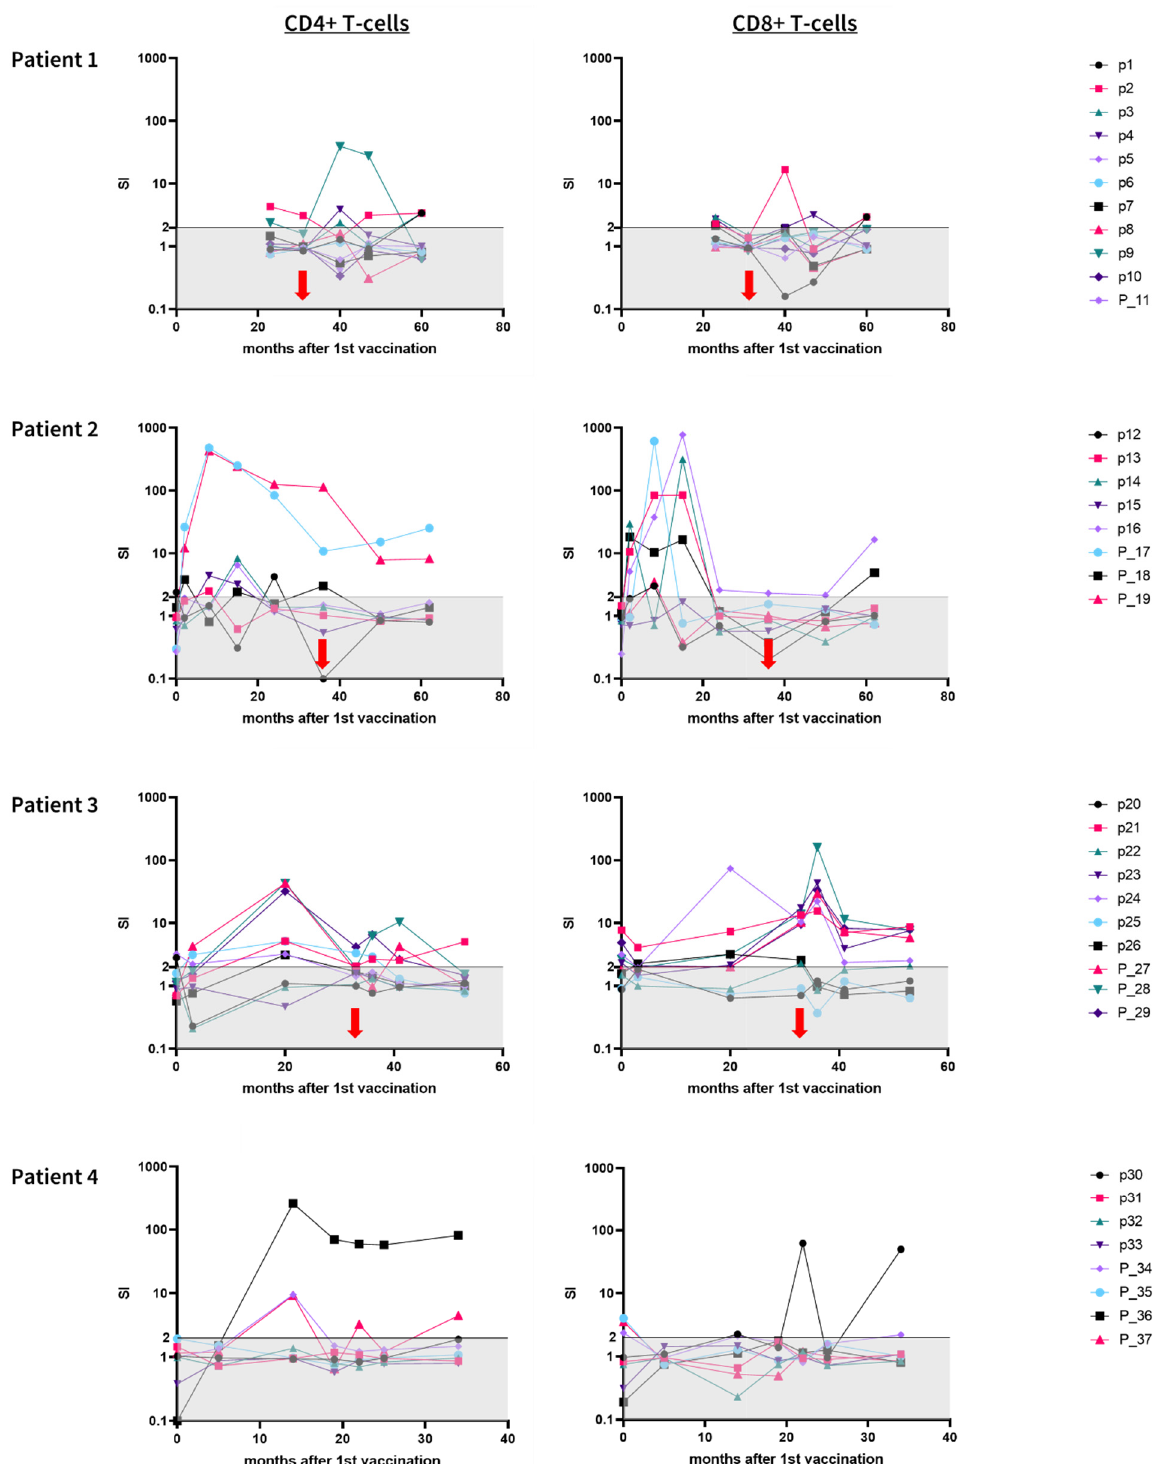
Figure 4. Stimulation index (SI) of vaccine-induced immune responses among individual patients over the course of vaccination. We distinguished between CD4+ ( left column ) and CD8+ ( right column ) immune responses. Neoantigen-specific T-cells were defined as being present if SI was ≥ 2 (gray area). p = short HLA class I peptide; P_ = long HLA class II peptide. Red arrow: date of last vaccination.